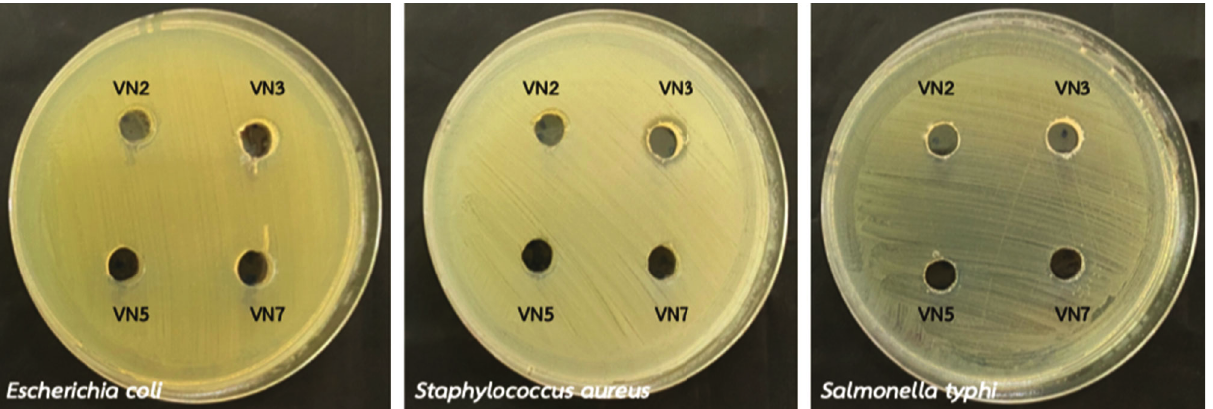
Figure 9: Pathogen bacterial inhibition of VN2, VN3, VN5, and VN7, respectively.